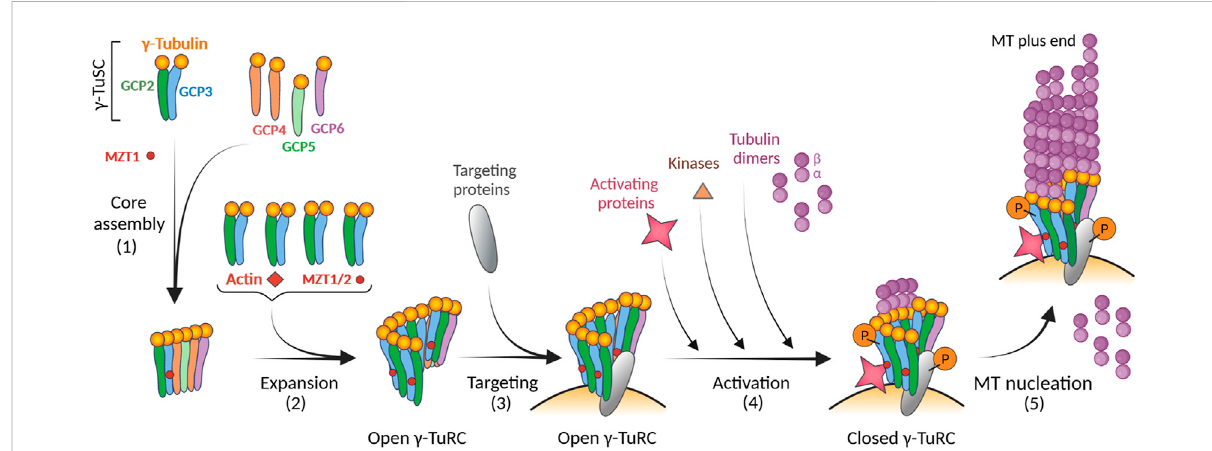
FIGURE 3 Model for the modular assembly of γ -TuRC and its activation. The fi rst step in the formation of γ -TuRC is the core assembly of the stable subcomplex from γ -TuSC (2 molecules of γ -tubulin and one copy each of GCP2 and GCP3), GCP- γ -tubulin heterodimers (spokes; one molecule of γ -tubulinandonecopyeachofGCP4,GCP5orGCP6),andMZT1 (1) .Duringtheexpansionphase,fouradditional γ -TuSCunits,MZT1/2,andactinare added (2) . The resulting γ -TuRCs with the open conformation are concentrated onto centrosomes via targeting proteins (e.g., CDK5RAP2, NEDD1) (3) . The pitch and diameter of open γ -TuRC are incompatible with those of assembled microtubules. This suggests that the complex undergoes a conformational change through its activation to reduce its diameter before microtubule nucleation. Different modes of activation, including direct binding of activating proteins (e.g., CDK5RAP2, NME7), phosphorylation of γ -TuRC by kinases, or increased concentration of αβ - tubulins, can result in a conformational change leading to a closed γ -TuRC (4) . Different types of activation may occur simultaneously.